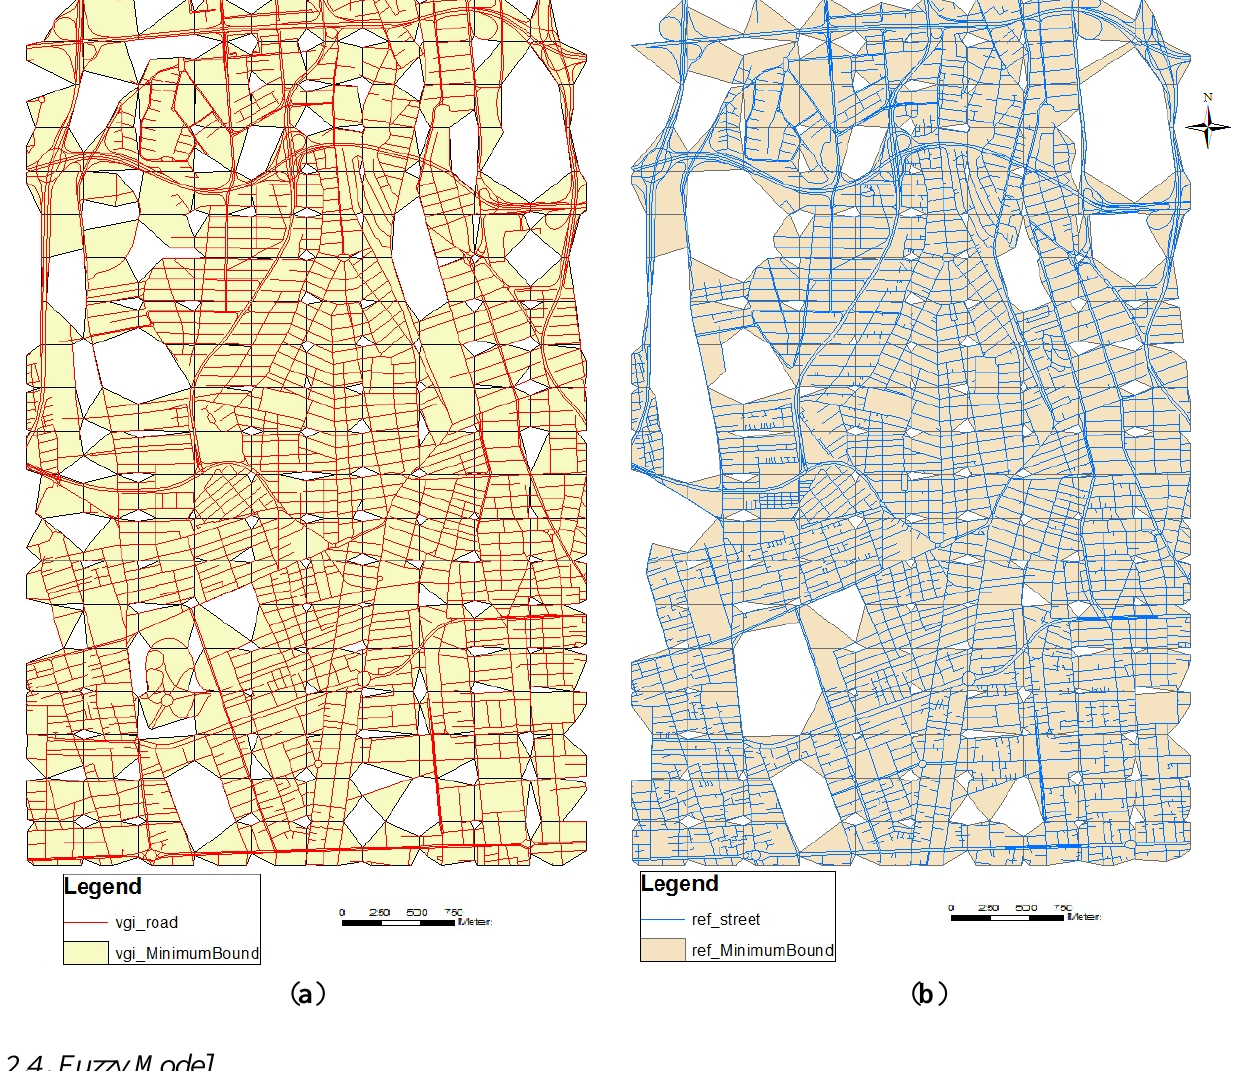
Figure 5. ( a ) Minimum bounding geometry for features of each tile for OSM. ( b ) Minimum bounding geometry for features of each tile for the reference